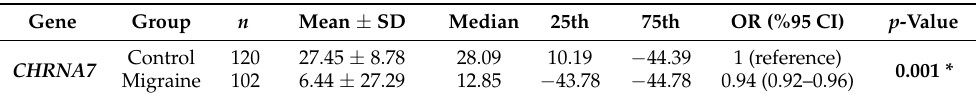
Table 3. CHRNA7 gene expression, minimum, maximum, and p values in migraine patient and control group.